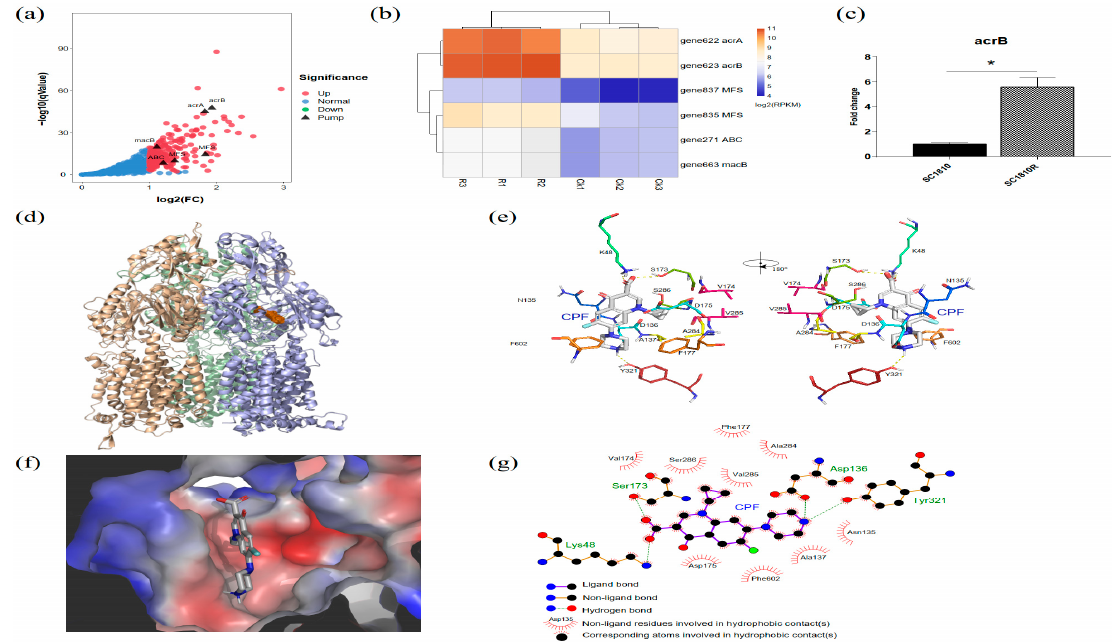
Figure 5. Analysis of differential expression genes of efflux pump ( a – c ) and prediction of crystal structure of CPF-bound AcrB ( d – g ). ( a ) Volcano plots marked with DEGs of pumps. ( b ) Each row represents the relative expression of single transcript, and each column represents a sample. Colors represent the log 2 -transformed gene expression level, with red and blue representing high and low expression levels, respectively. ( c ) Relative transcription levels of acrB . The data are expressed as the mean and standard deviation (SD) of 3 experiments (* p < 0.05). ( d ) Whole trimer structure of AcrB (ribbon model) bound with CPF (electron density map). ( e ) Close-up view of the CPF-binding site. Electron density of CPF (orange mesh) overlapped with stick models of LMNG (grey). ( f ) View of the bound CPF (grey), shown in the cut view of the surface model of the distal pocket in the binding monomer. The red indicates higher electron cloud density (gain electrons), whereas blue represents lower electron cloud density (electron loss). ( g ) 2D representation of the interaction between CPF and AcrB was drawn using LigPlot+ [31].